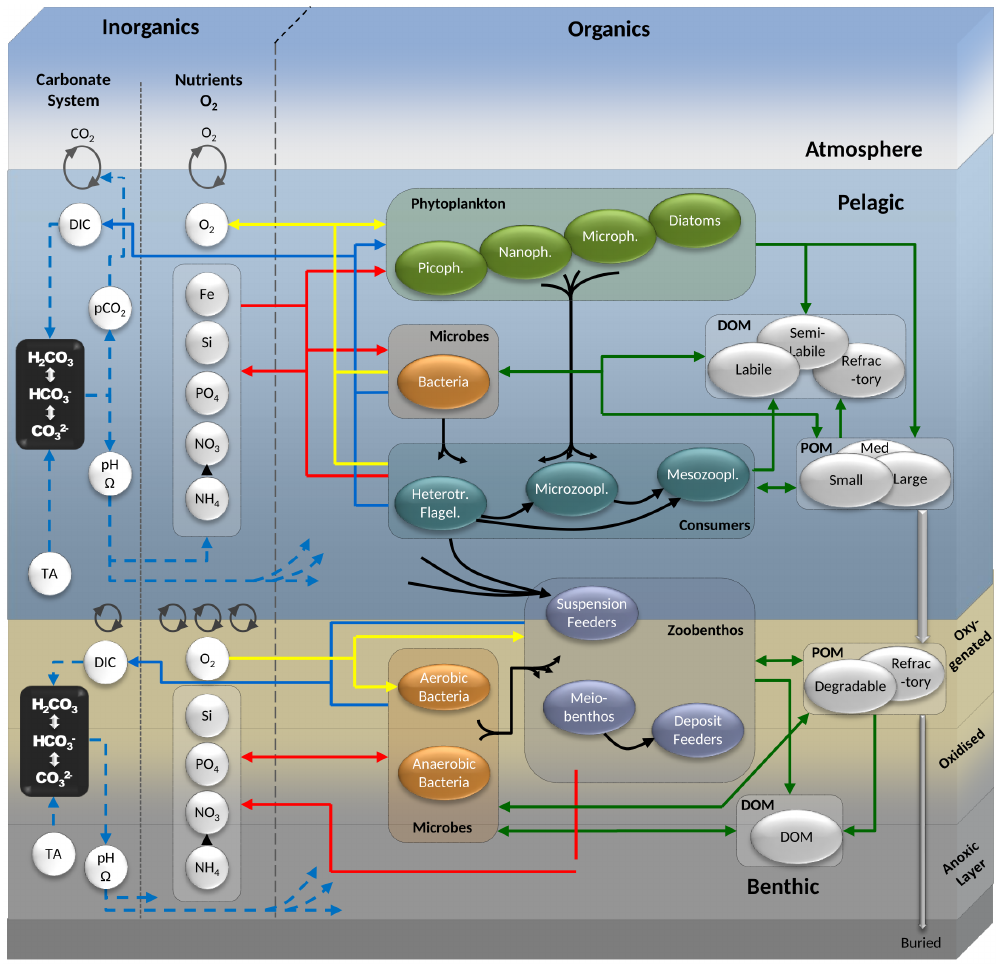
Figure 2. ERSEM schematic showing how model components interact with or influence each other. Blue connectors represent inorganic carbon fluxes, red represents nutrient fluxes, yellow represents oxygen, black represents predator–prey interactions, and green represents fluxes of non-living organics. Dashed arrows indicate the influence of carbonate system